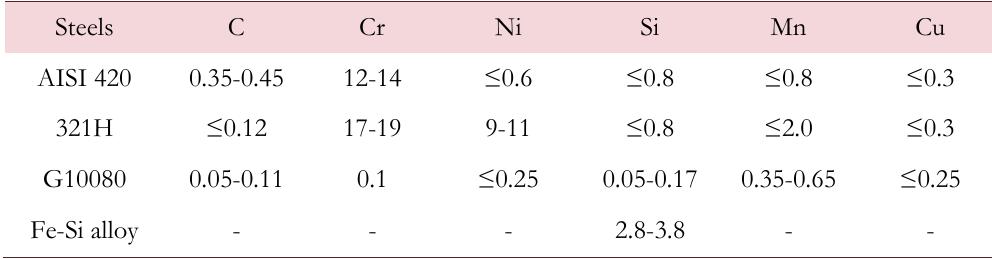
Table 1: Chemical compositions of experimental steels, in